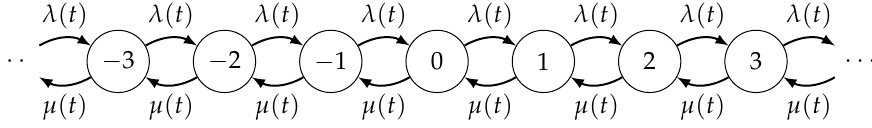
Figure 1. State diagram of the non-homogeneous double-ended queueing